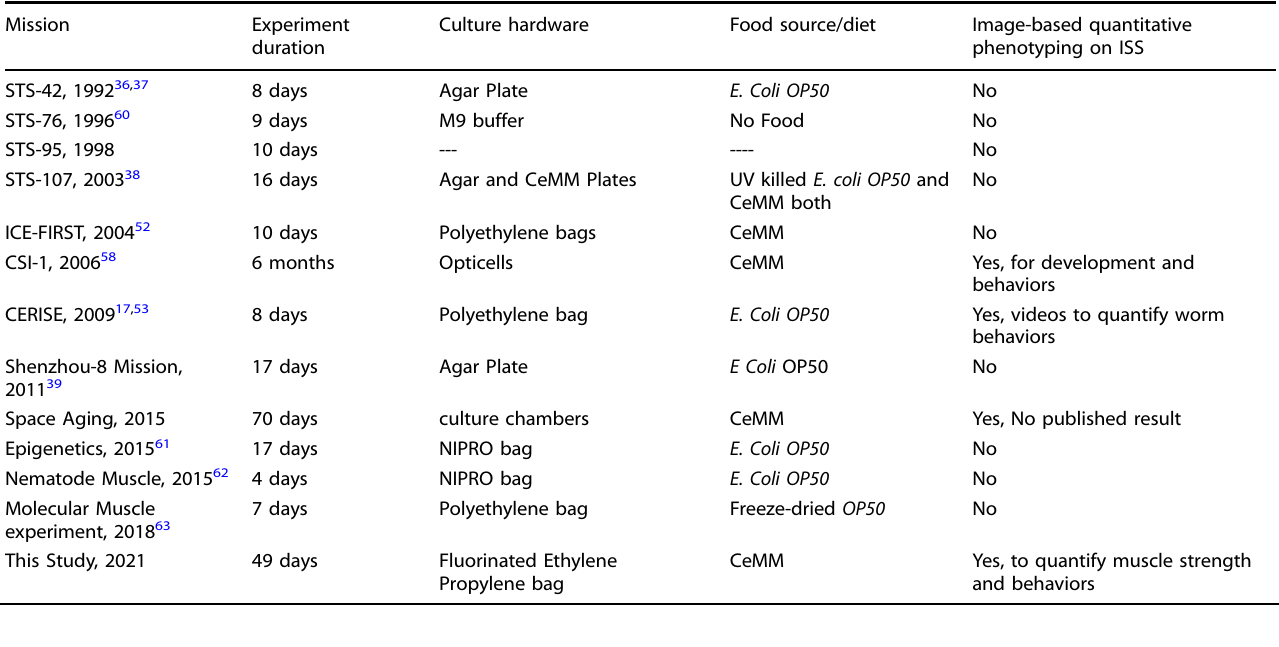
Table 1. Summary of previous space missions with C. elegans